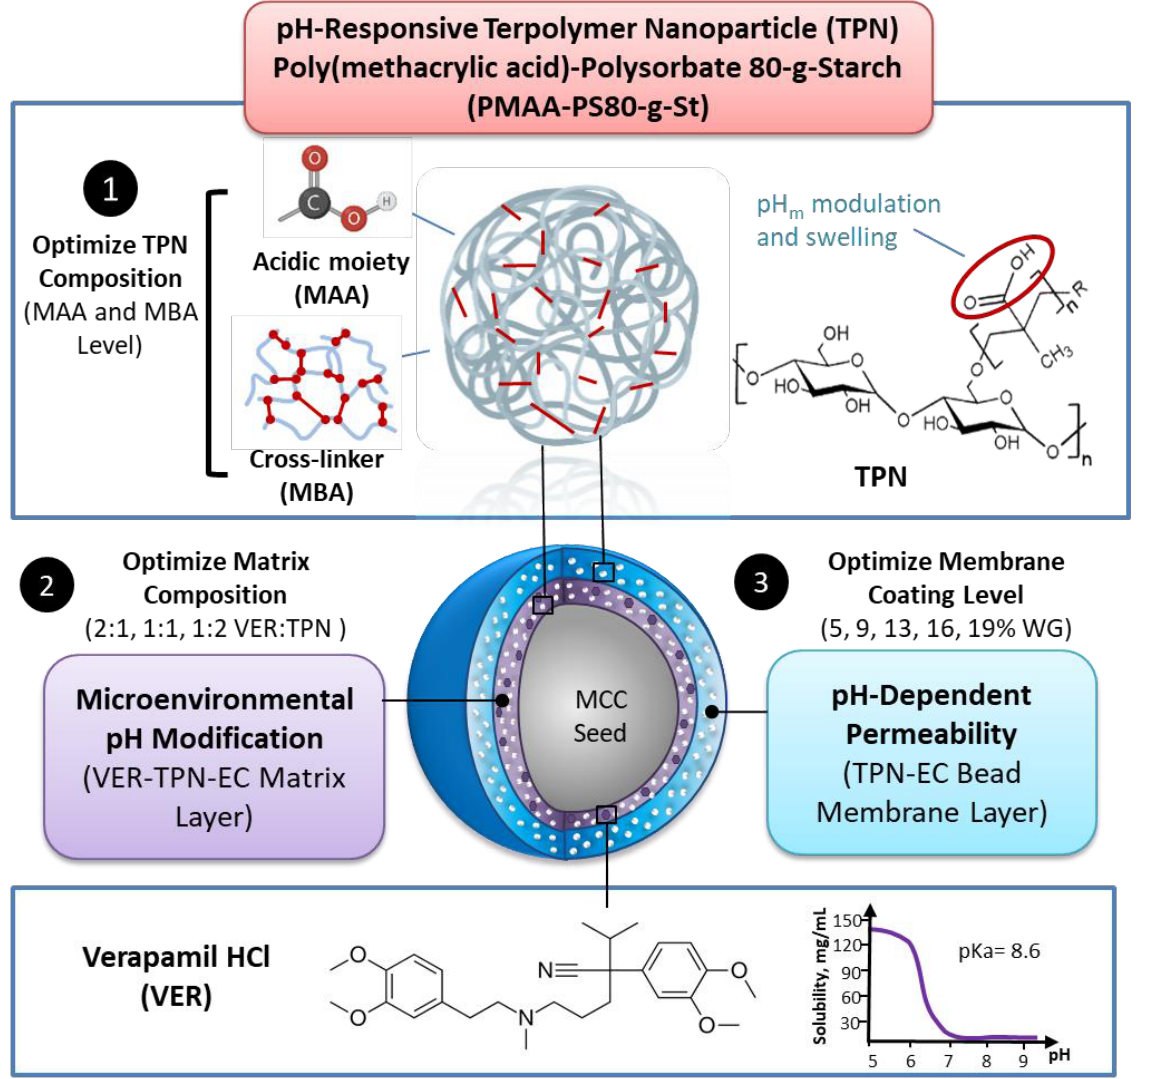
Figure 1. A flow chart of the optimization strategy to achieve pH transition-independent controlled release of VER from a TPN-containing bilayer-coated beads. Formulation strategy for TPN bilayer- coated beads containing weakly basic VER Optimization of TPN composition to achieve pH m modification and pH-dependent swelling, followed by strategic placement of TPN in the bilayer bead matrix and membrane layers are proposed to overcome pH-dependent solubility of VER. Figure created with BioRender.com (accessed on 15 December 2022).